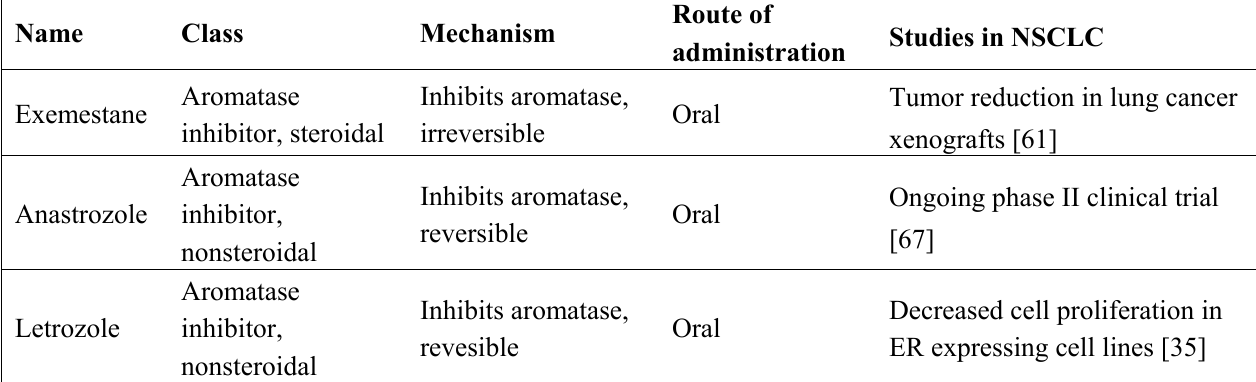
Table 3. Endocrine therapy in metastatic breast